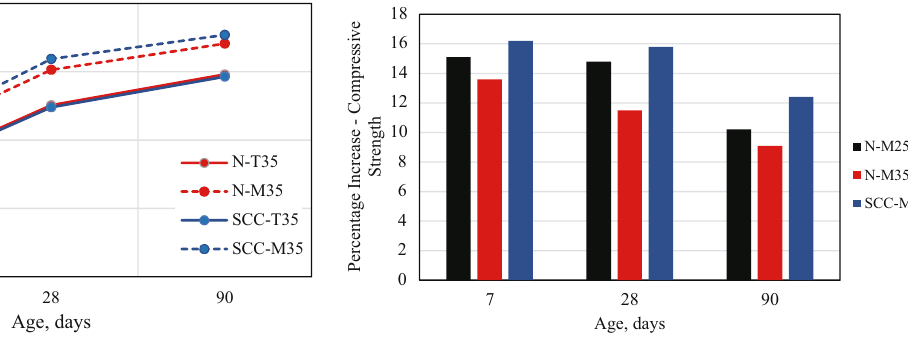
Figure 7: Compressive strength results for normal and SCC mixes using tap and magnetized water.